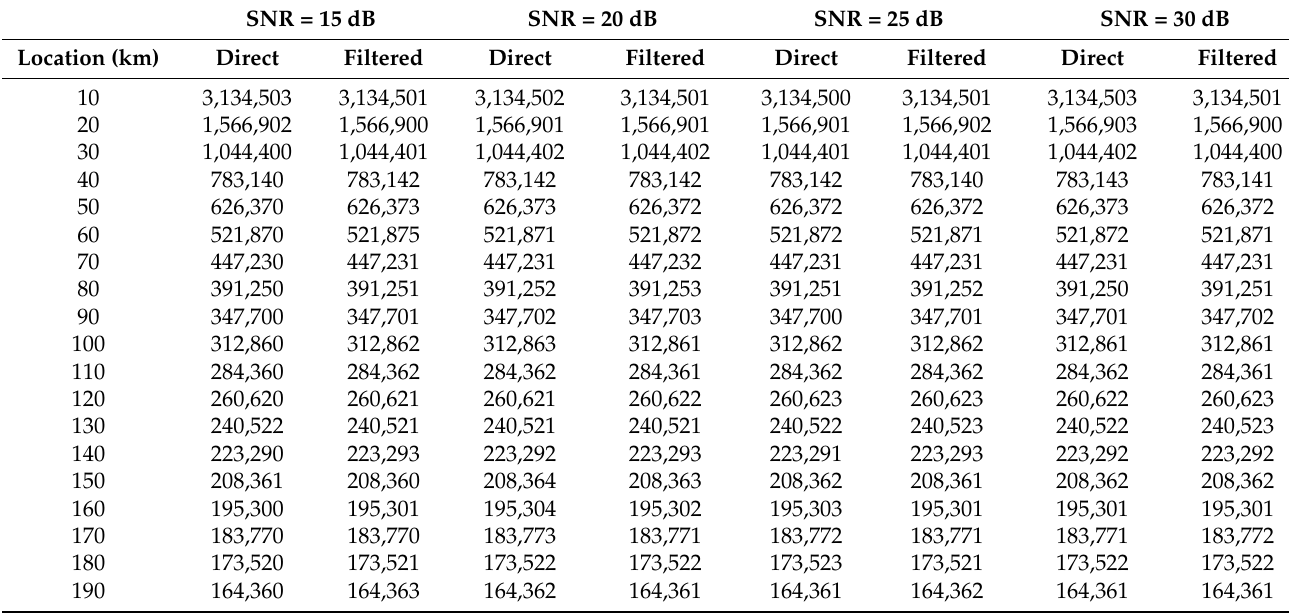
Table A4. Max singular value of FRFT-SVD results at various SNRs for direct and filtered signals under LLL-G fault scenario.